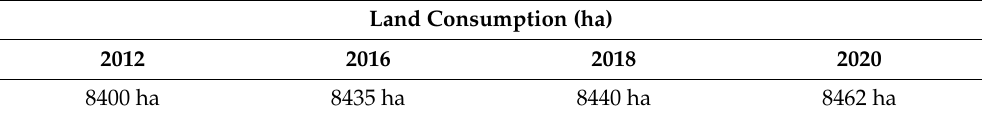
Table 19. Land Consumption